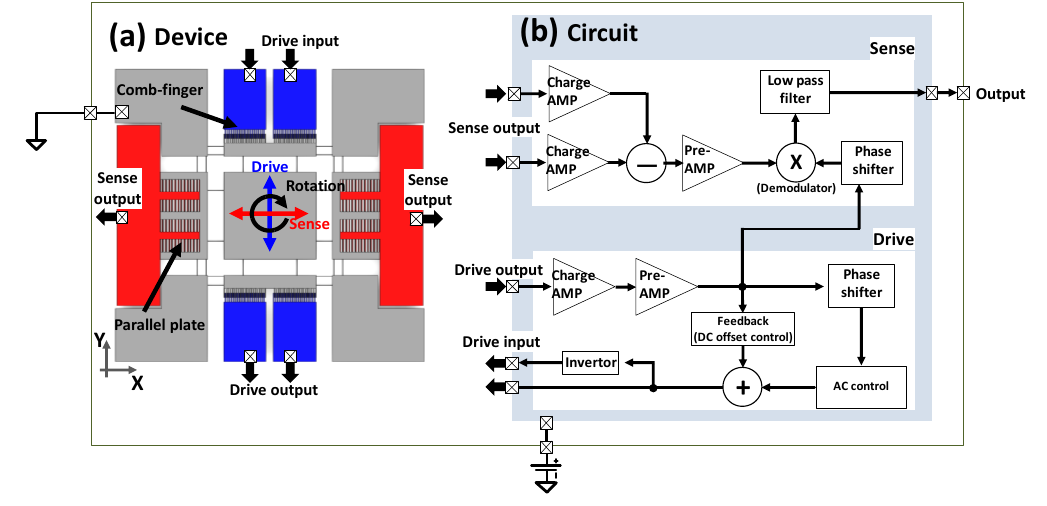
Figure 1. Package of the MEMS vibratory gyroscope system consisting of ( a ) a MEMS device and ( b ) an electrical circuit for self-oscillation at its natural frequency and for output-signal processing.